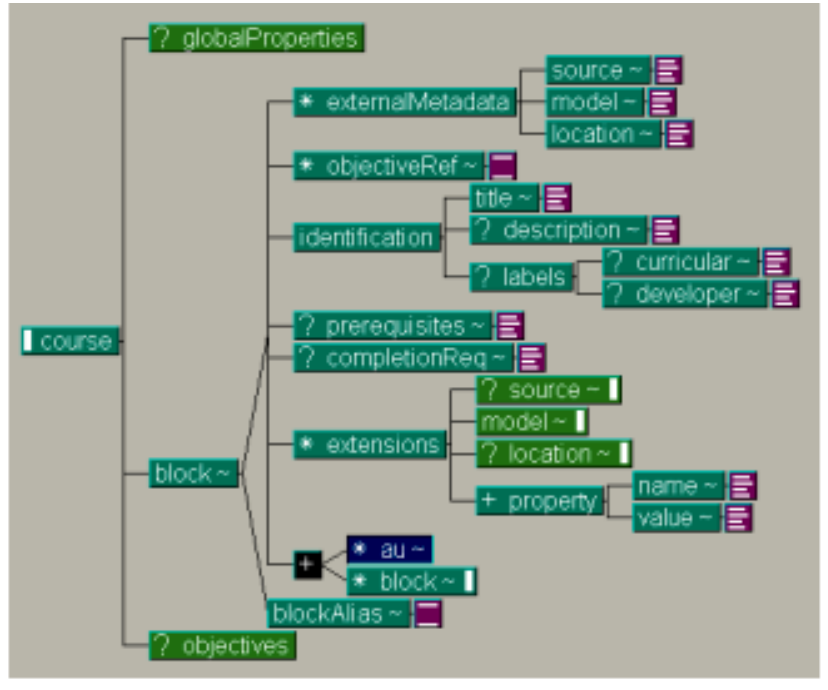
Figure 2: SCORM’s Global Properties